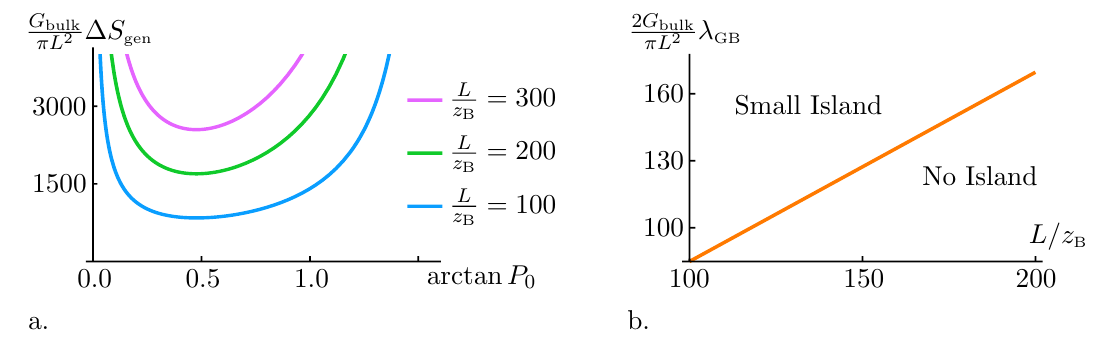
Figure 11 . Panel a. illustrates the renormalised area from eq. (4.54) of connected RT surfaces, anchored at (cid:16) = 0, with (cid:21) = 0. Panel b. is a plot of the critical value of (cid:21) CFT GB min((cid:1) S ) <